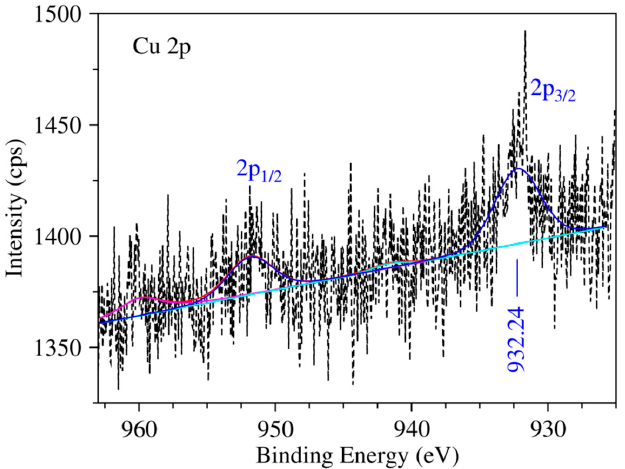
Figure 4. XPS spectrum of Cu 2 p core electrons for the fresh as-prepared catalyst [PrMIm]Cl-CuCl 2 . The binding energy of the observed 2 p 3 / 2 peak is 932.24 eV.